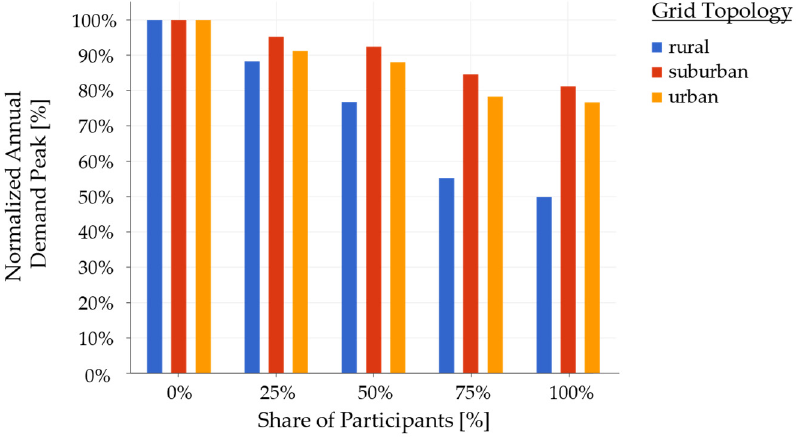
Figure 4. Annual demand peak reduction by ‘maximum grid-friendliness’ strategy depending on the renewable energy communities’ share of participants.